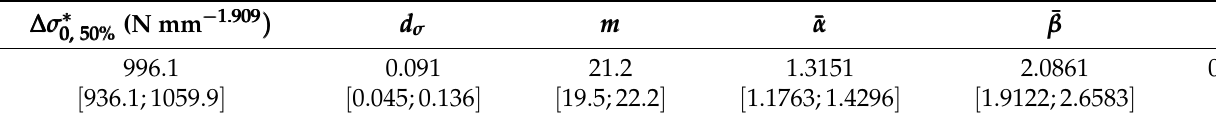
Table 1. Best-fitting of free-parameters entering Equations (8) and (9).